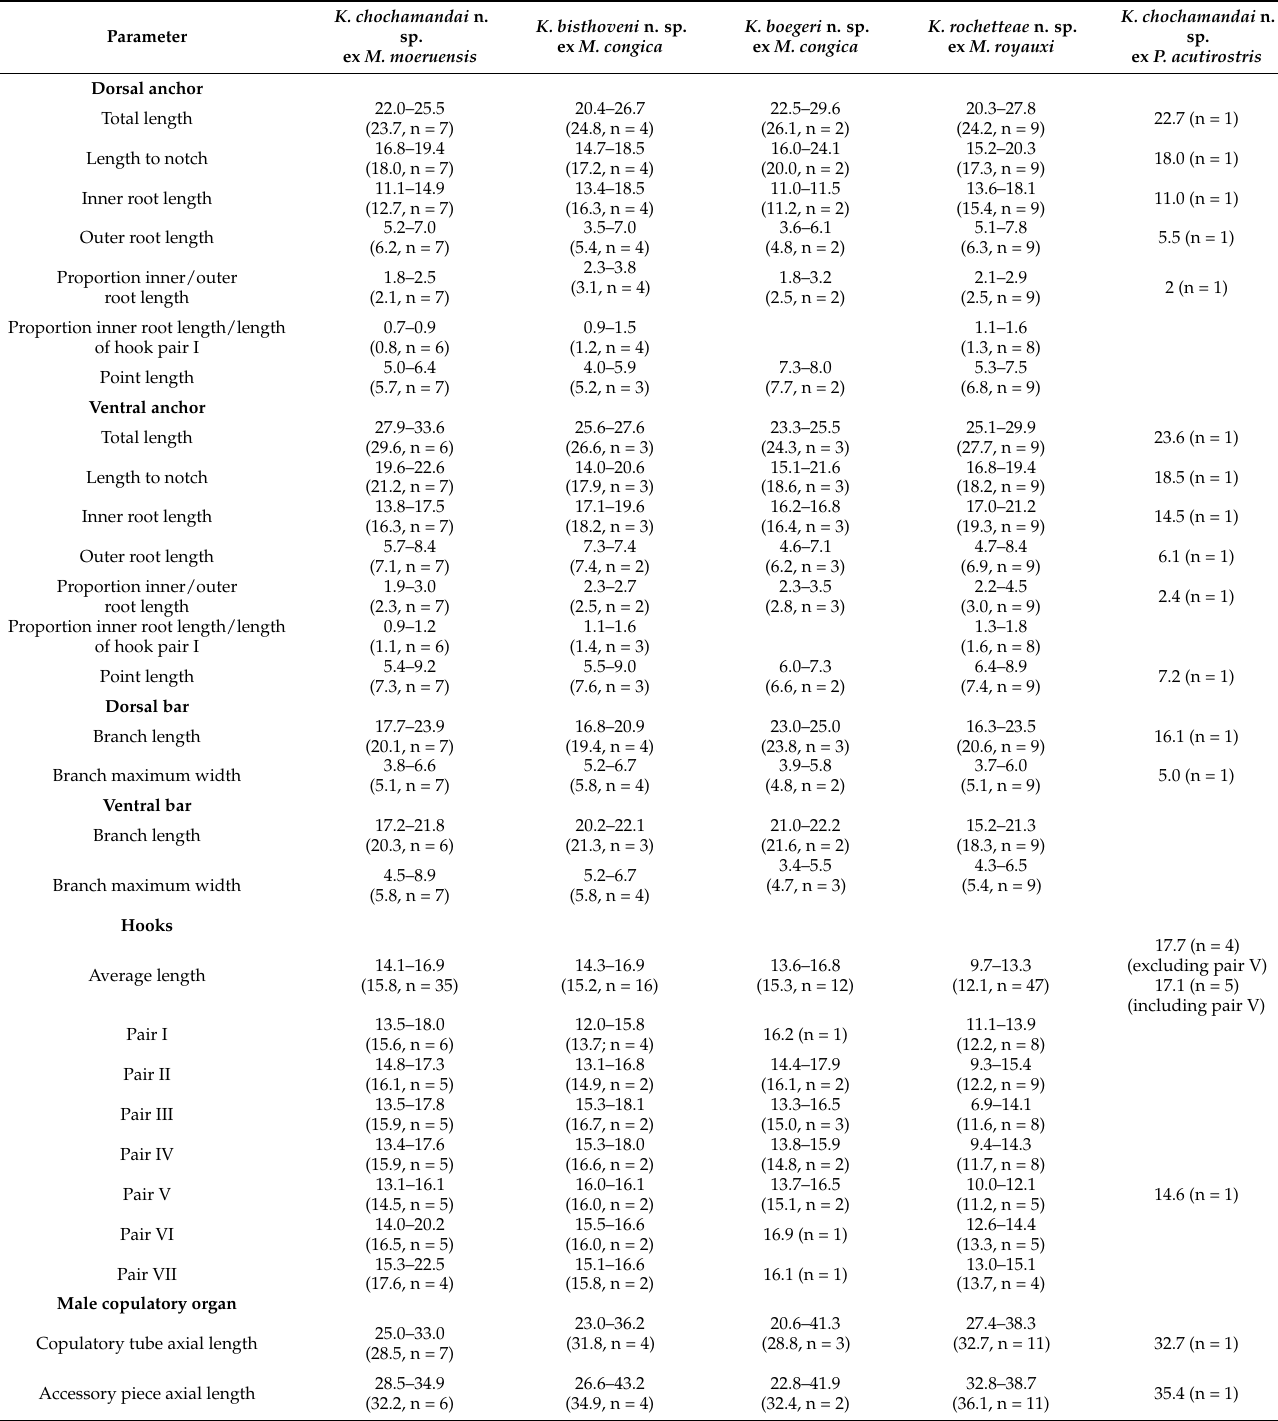
Table 4. Morphometric data ( µ m) for species of Kapentagyrus infecting members of Microthrissa or Potamothrissa . The measurements are presented as range followed by average and number of structures measured (n) in